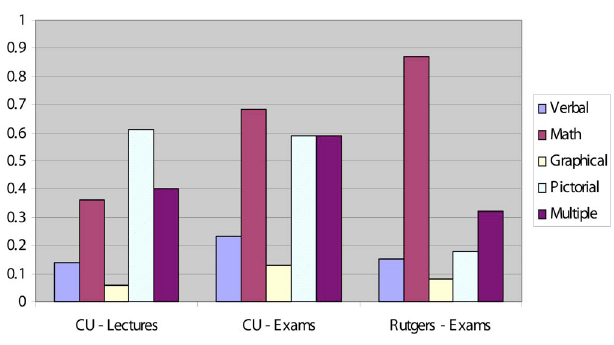
FIG. 4. (cid:1) Color (cid:2) Fraction of lectures and exams at CU and exams at Rutgers using verbal, math, graphical, pictorial, and